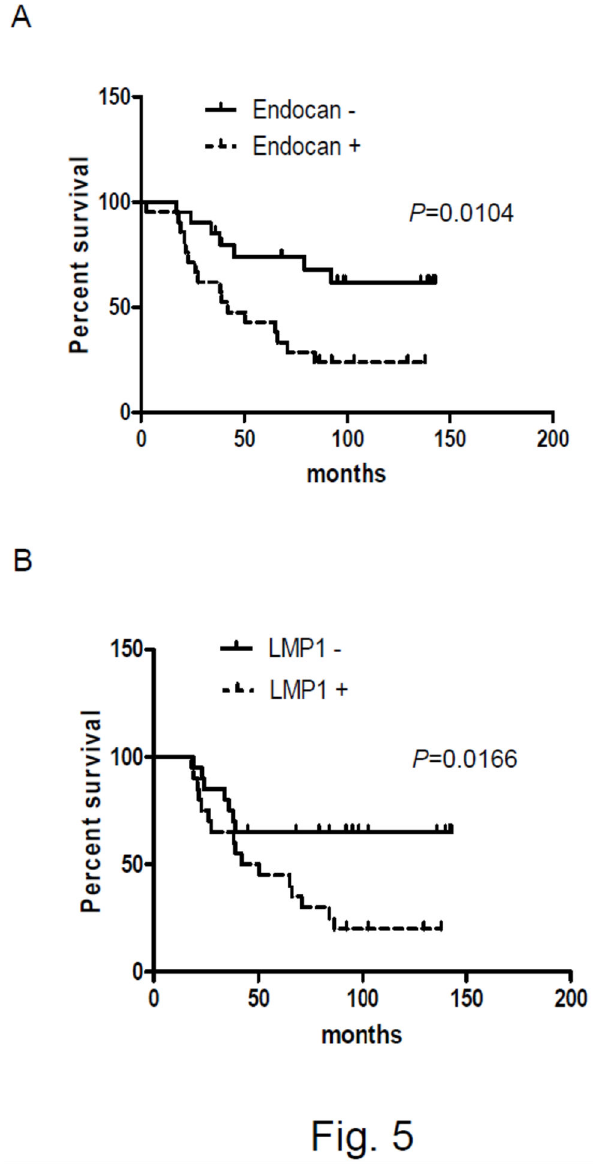
Figure 5. Relationship between survival and endocan expression or LMP1 expression in NPC patients. ( A ) Overall survival curve of endocan-positive (n=21; dotted line) and endocan-negative (n=20; solid line) NPC patients. A statistically significant difference was found between these two groups of patients ( P = 0.0104, log-rank test). ( B ) Overall survival curve of LMP1-positive (n=19; dotted line) and LMP1- negative (n=22; solid line) NPC patients. A statistically significant difference was found between these two groups of patients ( P = 0.0166, log-rank test).